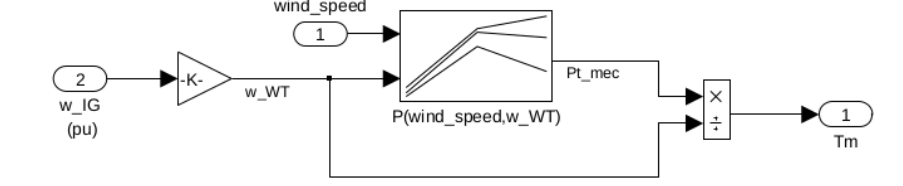
Figure 6. Wind turbine mechanical torque